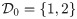
Financial network before default contagion occurs.(d−(v), d+(v)) are the degrees and e(v) is the initial equity of node v. The nodes in the initial default set D0={1,2} are marked in blue.